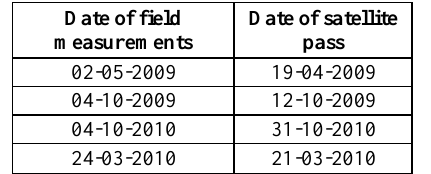
Table 1. The dates of field measurements and Land sat 7 acquisitions.